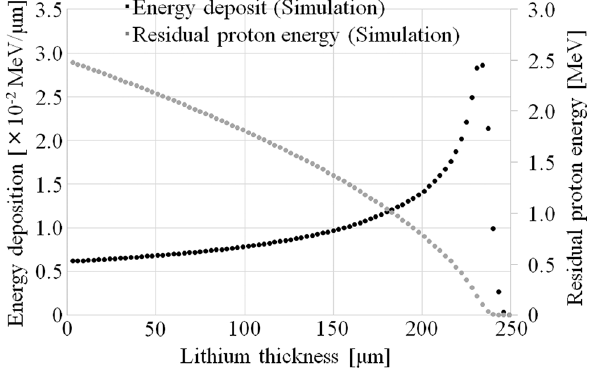
Figure 4. Proton energy depositions and residual proton energies at each Li thickness. The incident proton energy was 2.5 meV.